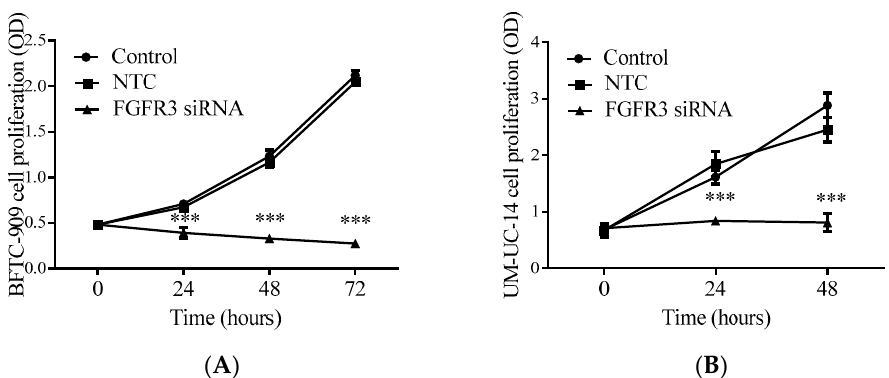
Figure 3. Suppressive effect of FGFR3 gene silencing on proliferation of cultured UTUC cells. Two UTUC cell lines, BFTC-909 ( A ) and UM-UC-14 ( B ), were treated with FGFR3-targeted siRNA or scramble non-target control (NTC), followed by a WST-1-based proliferation assay. Optical density (OD) measured is expressed as mean ± SEM ( n = 3). *** p < 0.001 compared with respective NTC groups.